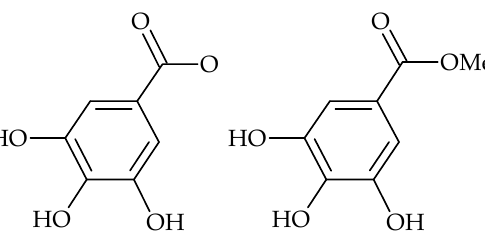
Figure 2. Chemical structures of gallic acid ( left ) and methyl gallate ( right ).